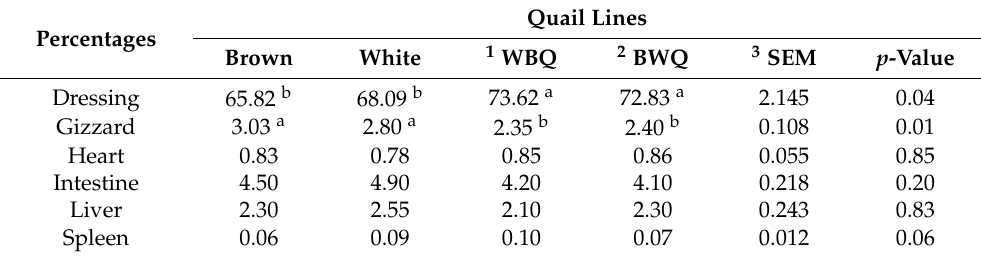
Table 4. Effect of crossing white and brown quail lines on carcass